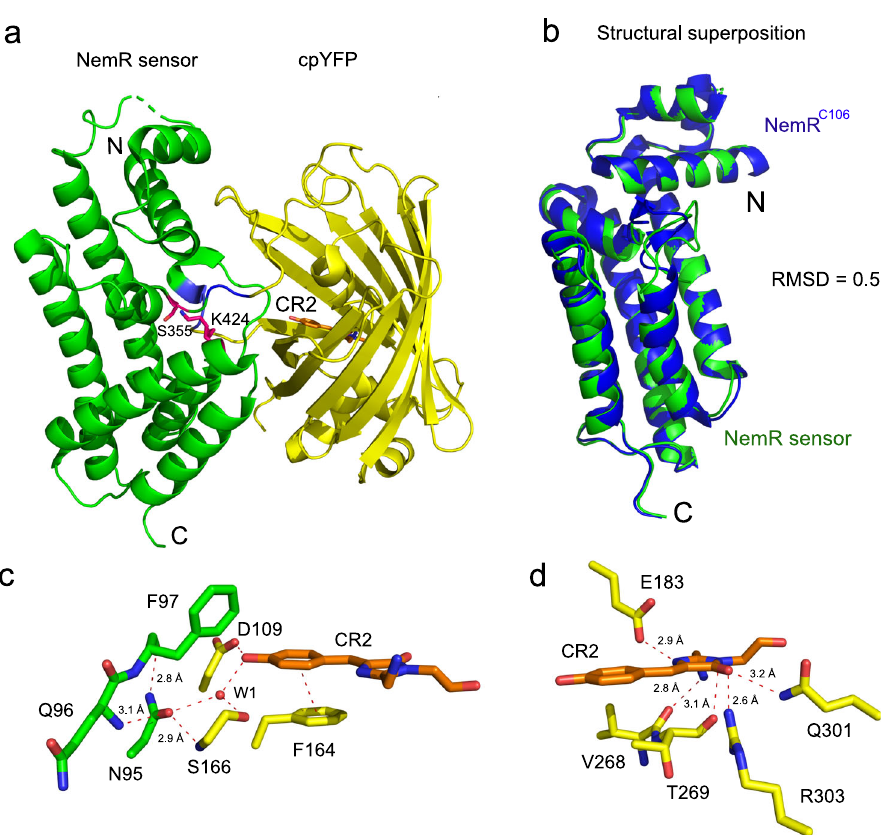
Fig. 4 The structure of HypocratesCS, a cpYFP-based biosensor (PDB ID: 6ZUI). a The NemR-sensor domain (green) and the cpYFP domain (yellow) are shown. The chromophore (CR2) in the cpYFP β -barrel is shown in orange stick representation. S355 (to which the reactive C355 was mutated to) and K424 (two orientations of the side chain) are shown in red stick representation. The linkers “ SAG ” and “ GT ” are colored blue. The N-terminal residues 1 – 7 and segments (residues 40-42 and 193 – 207) are missing. b Superposition of NemR C106 (blue – PDB ID: 4YZE) with the NemR-sensor domain (green). RMSD - root-mean-square deviation. c N95 connects the sensor domain (green) with cpYFP (yellow). N95 interacts with the backbone of Q96, F97 of the NemR-sensor domain and with S166 of the cpYFP domain. The 4-hydoxybenzyl group of CR2 interacts with the phenyl-ring of F164 over a distance of 3.8 Å. d The imidazolinone ring of CR2 interacts with R303, Q301, V268, E183, and